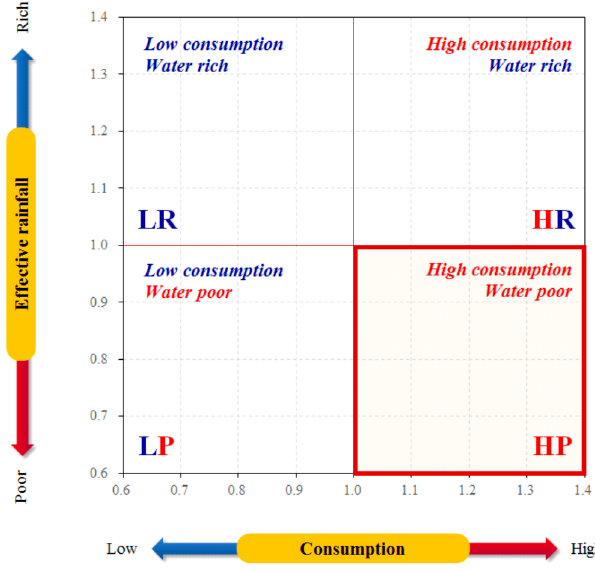
Figure 2. Categorizing model for sensitivity types of paddy rice.